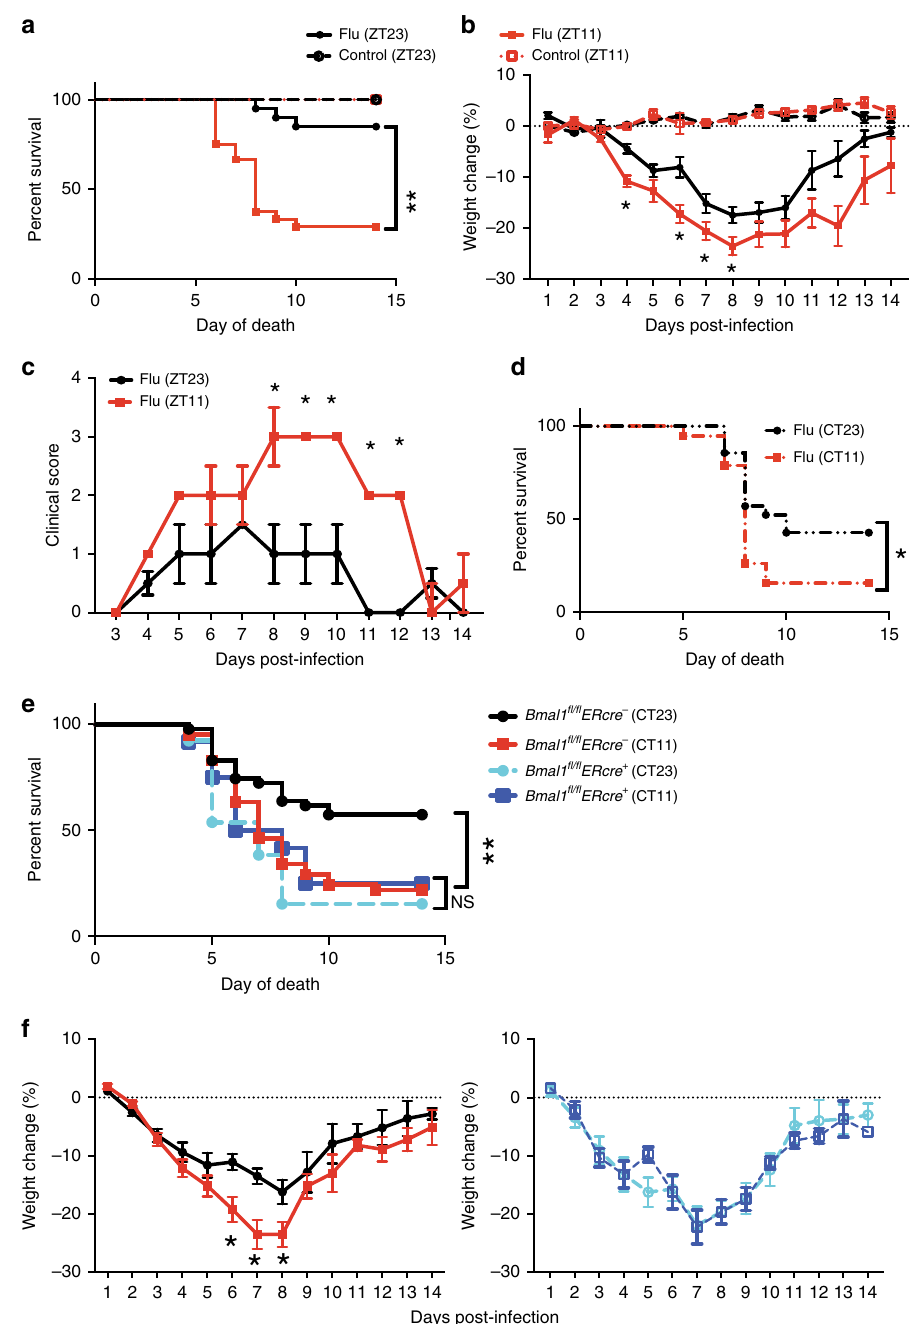
Fig. 1 Time of infection affects survival in in fl uenza A virus (IAV) disease. Experimental design: two groups of mice were maintained in 12 h light: dark cycles. Mice were infected with 40 PFU of IAV (PR8; H1N1) intransally (i.n.) at either the start of the light cycle (ZT23; ZT0 being the time at which light go on in a 12 h LD cycle) or at the start of the dark cycle (ZT11). Mice infected at ZT11 were always weighed and scored at ZT11 at serial time points following infection and likewise for ZT23 group. This ensured that the time from infection to evaluation was identical for both groups. a Survival curves are a composite of three independent experiments [total n = 8/control group; n = 20 – 24/IAV group, log-rank (Mantel – Cox) test, p < 0.0001]. b Disease progression is expressed as the percent of weight change following IAV infection. c Disease progression was also measured as clinical scores. The data represented as median± SEM (total n = 17 per group; Student ’ s t test, * p < 0.05, ** p < 0.01, *** p < 0.001). d Two groups of mice were maintained in constant darkness for 72 h, and were infected i.n. with 40 PFU of IAV (PR8) either at the times corresponding to start of the light cycle (CT23) or the start of dark cycle (CT11). Survival curves composite of two independent experiments [total n = 8 – 12 per group, log-rank (Mantel – Cox) test, * p < 0.05]. e , f Experimental design: Bmal1 fl / fl ERcre + mice and their cre − littermates were treated with tamoxifen at 6 – 8 weeks of age, and acclimatized to reverse cycles of 12 h LD for 2 weeks. Thereafter, they were maintained in constant darkness for 2 – 4 days prior to administering IAV (PR8) at CT23 and CT11. e Survival ( f ) weight change trajectory [ n = 12 – 13 in cre + group and n = 41, 47 in cre − group from three independent experiments]. Compiled data are expressed as mean ± SEM in panel b and f . Source data are provided as a Source Data fi